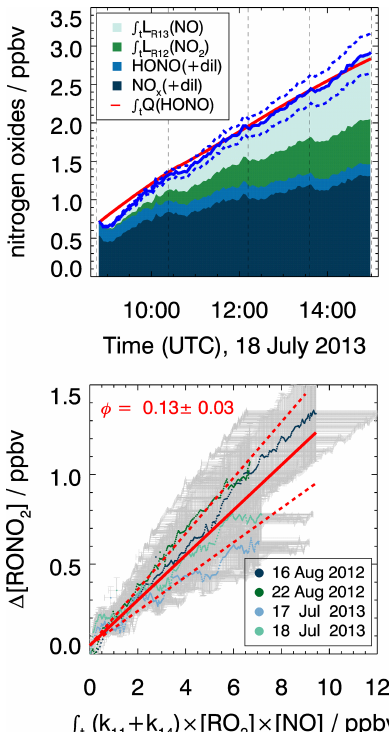
Figure 9. Determination of the organic nitrate yield from the pro- duction of nitrogen oxide species ( Q( HONO ) ) in the chamber ex- periment. Upper panel: example of cumulated reactive nitrogen ox- ide mixing ratios over the course of the experiment on 18 July 2013. The blue line denotes the total production of nitrogen oxides in- cluding organic nitrate applying a nitrate yield ( (cid:56) RONO2 ) of 0.13. Dashed lines show the error of the total nitrogen oxide calculation. Lower panel: scatter plot of the integrated turnover rate of the reac- tion of RO 2 with NO vs. the unaccounted nitrogen oxide mixing ra- tios ( (cid:49) NO y , Eq. 8). Results from all four experiments are included. The organic nitrate yield is determined by the slope of regression analysis (red line, R 2 = 0 . 92). Error bars denote experimental un- certainty derived from the accuracy of the measurements (Table 2) and dashed red lines the resulting uncertainty in the slope of the regression